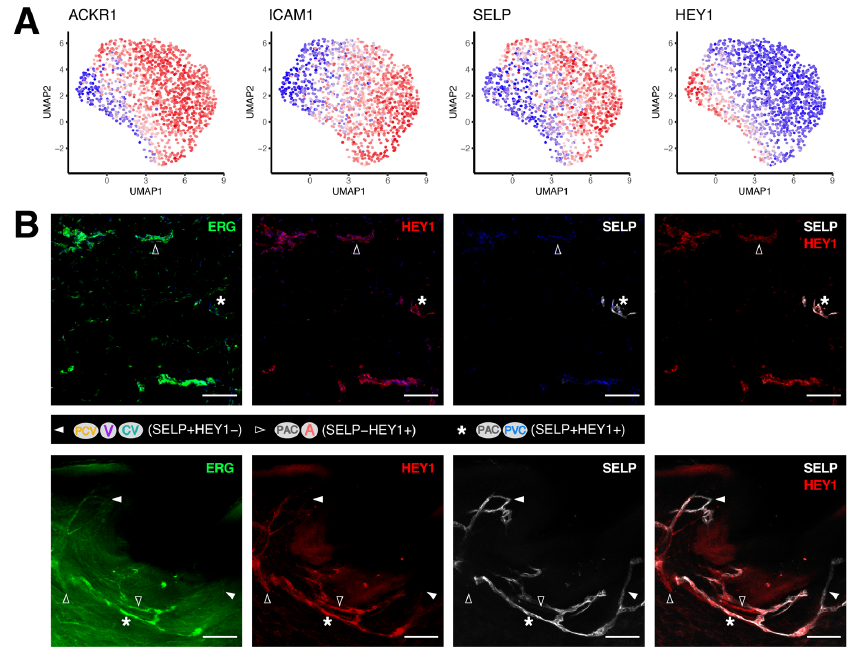
Figure 2. Venular and non-venular endothelial cells in adult human skin can be distinguished by conventional markers. ( A ) Expression patterns of the venular marker ACKR1, the adhesion molecules ICAM1 and SELP and the arterial marker HEY1. ( B ) Representative section (upper) and whole-mount staining (lower) of the pan-endothelial marker ERG (green), HEY1 (red) and SELP (white) distinguish individual BV compartments. White arrowheads, empty arrowheads and asterisks indicate the SELP+HEY1 − , SELP − HEY1+ and SELP+HEY1+ populations, respectively. Scale bars: 100 µm.